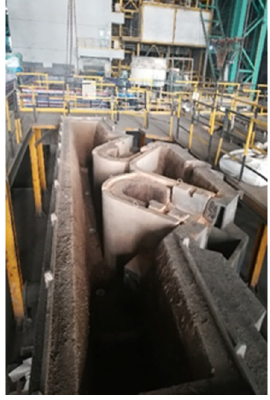
Figure 24. Improved tundish structure picture.